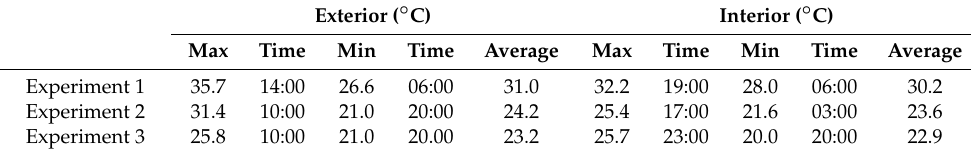
Table 4. Comparison of surface temperature in each